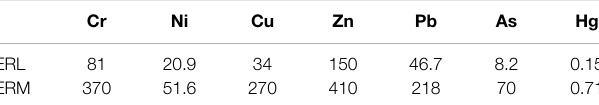
TABLE 2 | ERL (effects range low) and ERM (effects range median) guideline values for trace metals ( μ g/g in dry weight). Cr